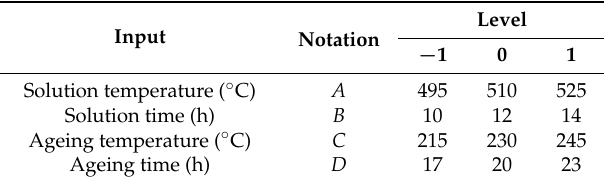
Table 4. Levels of variables chosen for Box-Behnken Design.